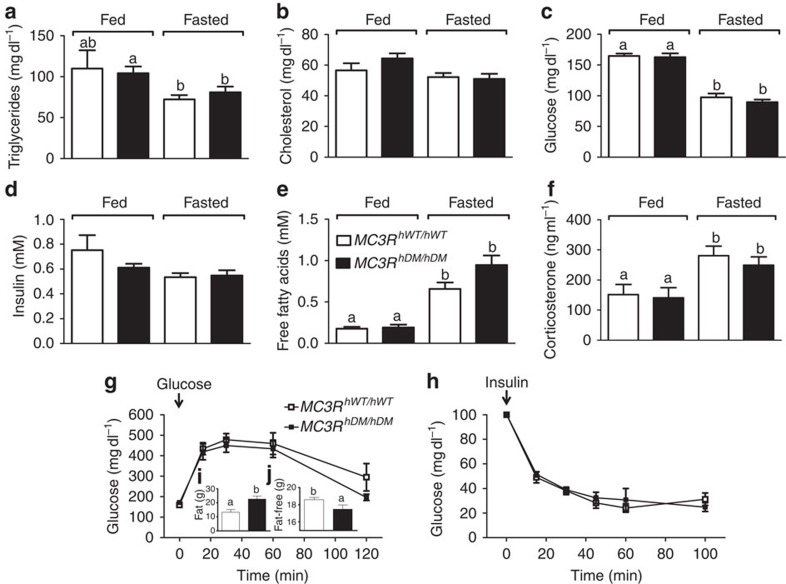
Maintained insulin sensitivity and circulating lipid and hormone profile in MC3RhDM/hDM mice.Serum samples were used to measure (a) triglycerides, (b) total cholesterol, (c) glucose, (d) insulin, (e) free fatty acids and (f) corticosterone in 3-month-old female MC3RhWT/hWT (open symbols) and MC3RhDM/hDM (closed symbols) mice. For MC3RhWT/hWT
n=8 except n=6 for triglycerides and corticosterone; for MC3RhDM/hDM
n=9. For glucose (g) and insulin (h) challenge tests (n=7 per group), glucose and insulin were injected at time 0. Fat mass (i) and fat-free mass (j) were determined on the day of the glucose tolerance test. Data are represented as mean±s.e.m. A different letter represents significant differences at P<0.05 compared to the other groups. Groups were compared with one-way (a–f) and two-way (g–h) analysis of variance followed by Bonferroni post-tests and Student's t-tests (two-tailed) (i,j).